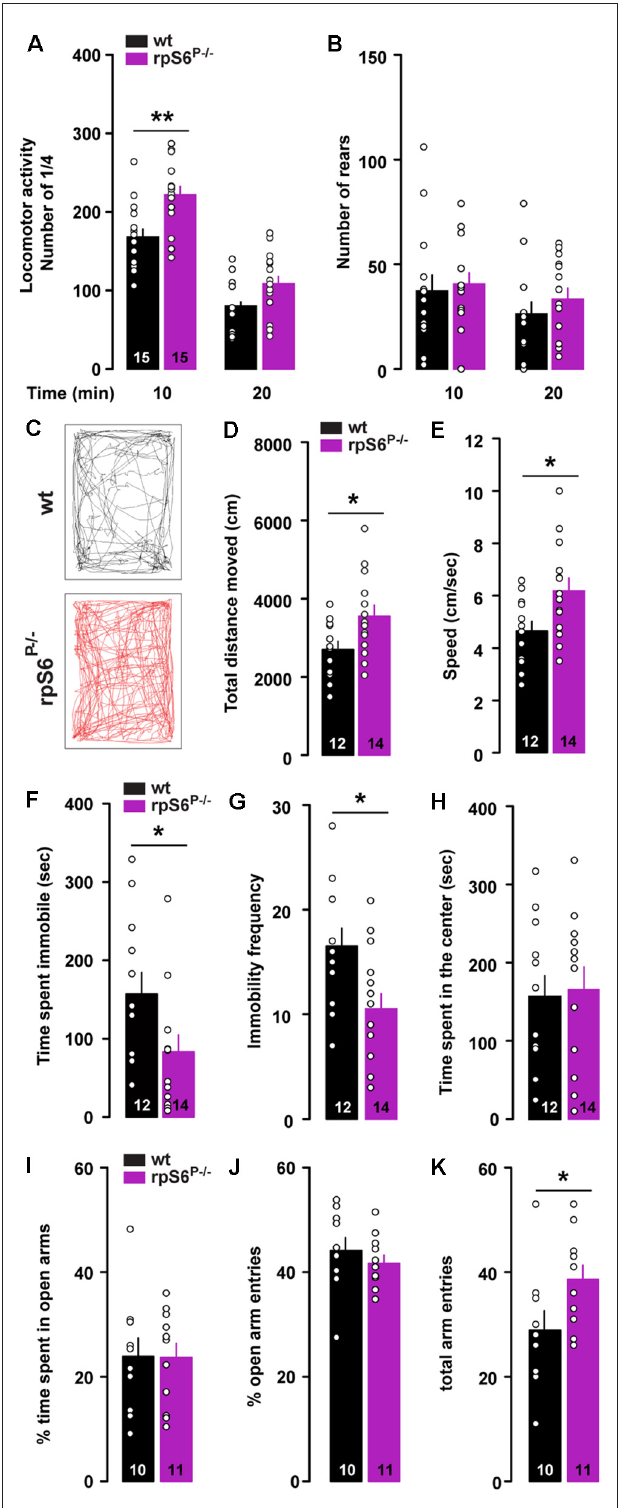
FIGURE 1 | Enhanced novelty-induced locomotion in rpS6 P − / − mice. (A) Horizontal and (B) vertical (number of rears) locomotor activity in wild-type (wt, black) and rpS6 phospho-deficient mice (rpS6 P − / − , magenta)